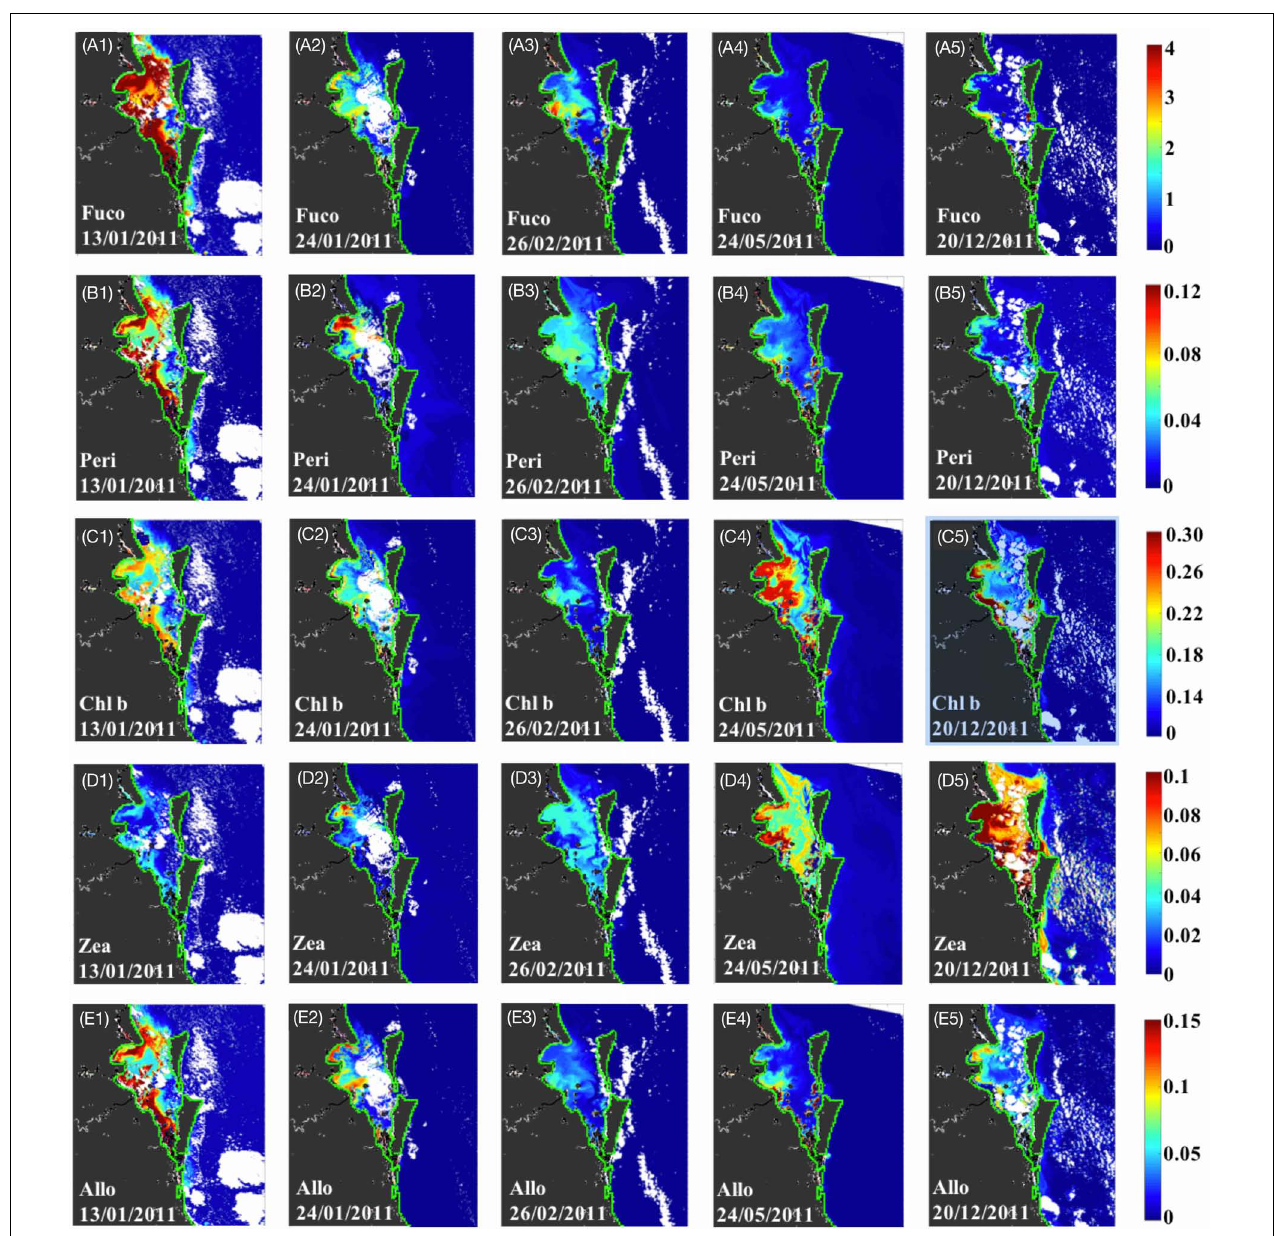
FIGURE 7 | MERIS-derived maps of diagnostic pigment concentrations for Moreton Bay. Simulated (A 1– A 5 ) fucoxanthin, (B 1– B 5 ) peridinin, (C 1– C 5 ) Chl-b, (D 1– D 5 ) zeaxanthin, and (E 1– E 5 ) alloxanthin. Vertical panels 1–5 represent maps for 13 January (1-week post flood), 24 January (2-weeks PF), 26 February (5-weeks PF), 24 May (19-weeks PF), and 20 December 2011 (48-weeks PF), respectively and horizontal panels (A–E) represent the different pigments; note the different concentration scale for each